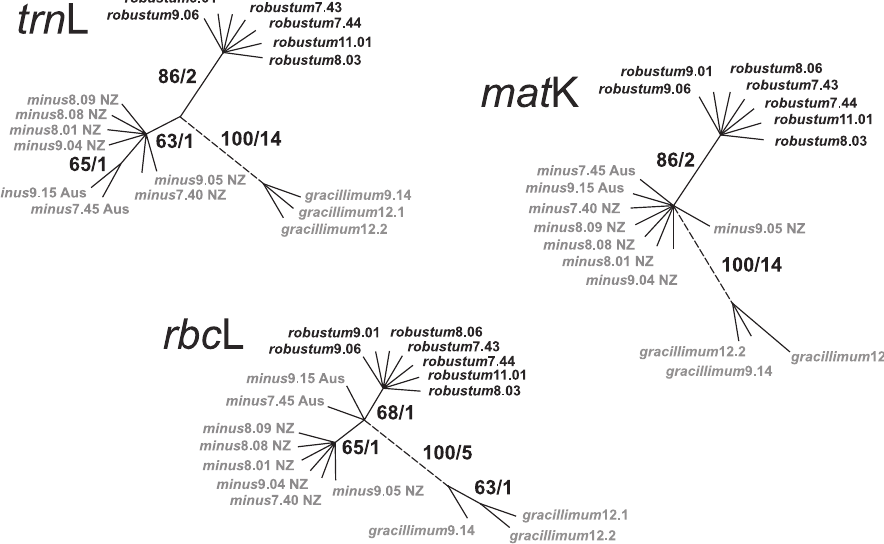
Figure 4. Comparison of median networks from independent analyses of trn L, rbc L and mat K sequenc- es. Bootstrap values / the number of mutations distinguishing each haplotype. are shown beside the branches. The accessions of Empodisma minus from New Zealand are indicated NZ and Australia